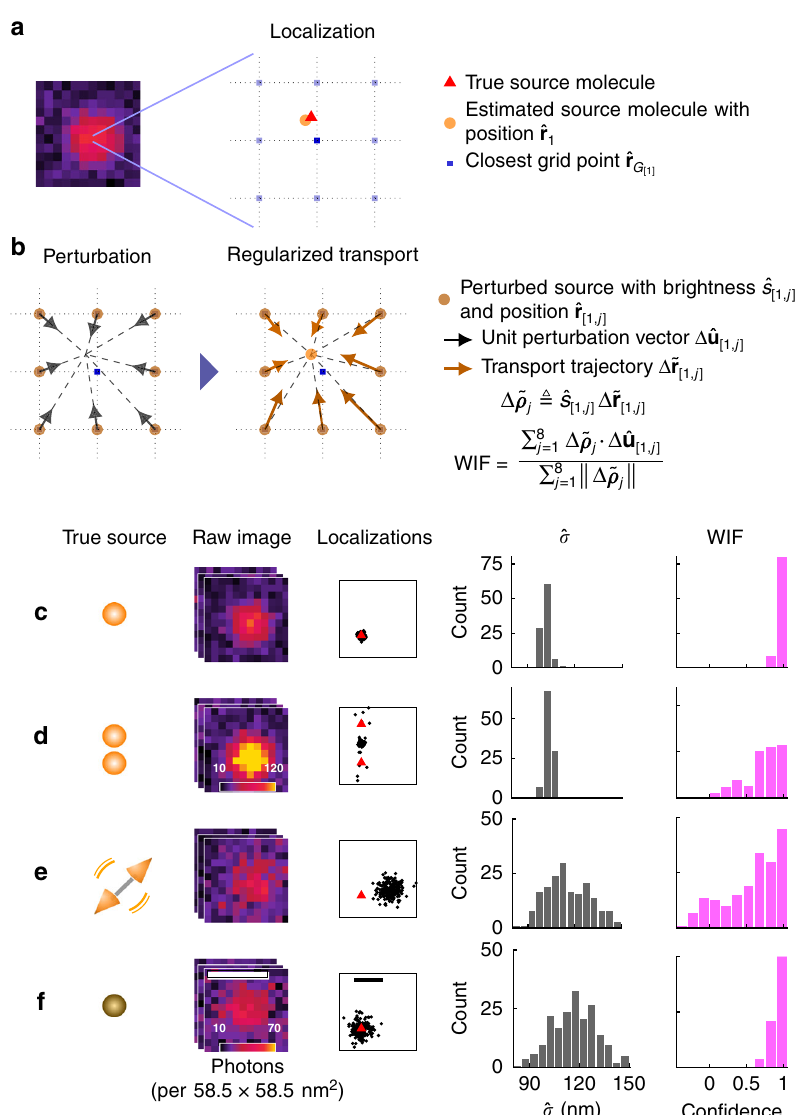
Fig. 1 Quantifying con fi dence in single-molecule localization microscopy (SMLM). a Left: Simulated image of a single molecule (SM, position denoted by red triangle) with isotropic emission. Right: Localization (orange circle) refers to a position ^ r and brightness ^ s estimate returned by an SMLM algorithm. 1 1 b Proposed con fi dence quanti fi cation framework. Localizations are represented as positions and brightnesses referenced to a grid without loss of generality (pale blue squares, “ Methods ” ). Left: A perturbation divides the photons of each estimated source molecule equally across eight neighboring grid points with brightnesses ^ s ½ 1 ; j (cid:2) at positions ^ r ½ 1 ; j (cid:2) . Middle: The perturbed source molecules are fed to a regularized transport optimization algorithm that minimizes a regularized negative log likelihood using its own PSF model, resulting in transport trajectories Δ ~ r ½ 1 ; j (cid:2) . Wasserstein-induced fl ux (WIF) measures the normalized amount of inward photon fl ux from the neighboring perturbed source molecules, taking values from − 1 (least con fi dence) to 1 (highest con fi dence). c – f Examples of localizing and quantifying con fi dence. c 100 simulated images of an isotropic, in-focus SM analyzed by ThunderSTORM (TS). Scatter plot: localizations (black dots) and true positions of the molecules (red triangles). Gray histogram: fi tted widths of the PSF ( ^ σ ) estimated by TS. Magenta histogram: estimated WIF con fi dences using the proposed method. d Similar to ( c ) but for two molecules separated by 70 nm. e Similar to ( c ) but for a dipole-like molecule defocused by 200 nm. f Similar to ( c ) but for a dim isotropic molecule in focus. Color bars: a , c , d and e , f photons per 58.5 × 58.5 nm 2 . Scale bars: a and f left: 500 nm, f right: 50